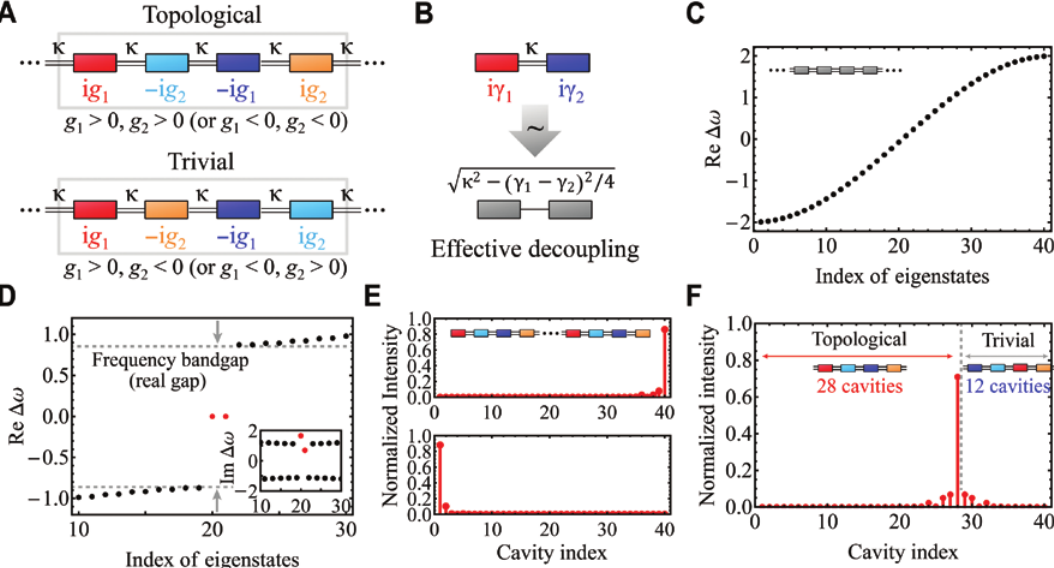
Figure 10: Gain- and loss-induced 1D photonic topological insulating phase [104]. (A) Four-cavity unit cell of the model. Top and bottom: topologically nontrivial and trivial systems, respectively. (B) Reduction of frequency splitting of supermodes by the contrast of imaginary potential. It works as effective decoupling that is especially enhanced when the signed magnitudes γ and γ have opposite signs (i.e., the cavities have gain and loss). (C) Eigendetuning of the system of 40 cavities with open 1 2 ends and no gain or loss. It traces the system band structure that is gapless and cosinusoidal. κ = 1. (D) Complex eigendetuning profile of the same lattice with the gain and loss introduced, so that the system becomes topologically nontrivial. It has a bandgap in Re Δ ω (real gap), = 2, g = 1. (E) Intensity distributions of the edge states in (D). Each of and the red dots correspond to the topological edge states. κ = 1, g 1 2 them localizes at each edge of the lattice. (F) A topological defect state formed at the interface between topological and trivial parts in a single cavity array. Their photonic topology depends solely on the gain and loss; thus, the position and number of such topological states can be controlled by the pumping profile of the